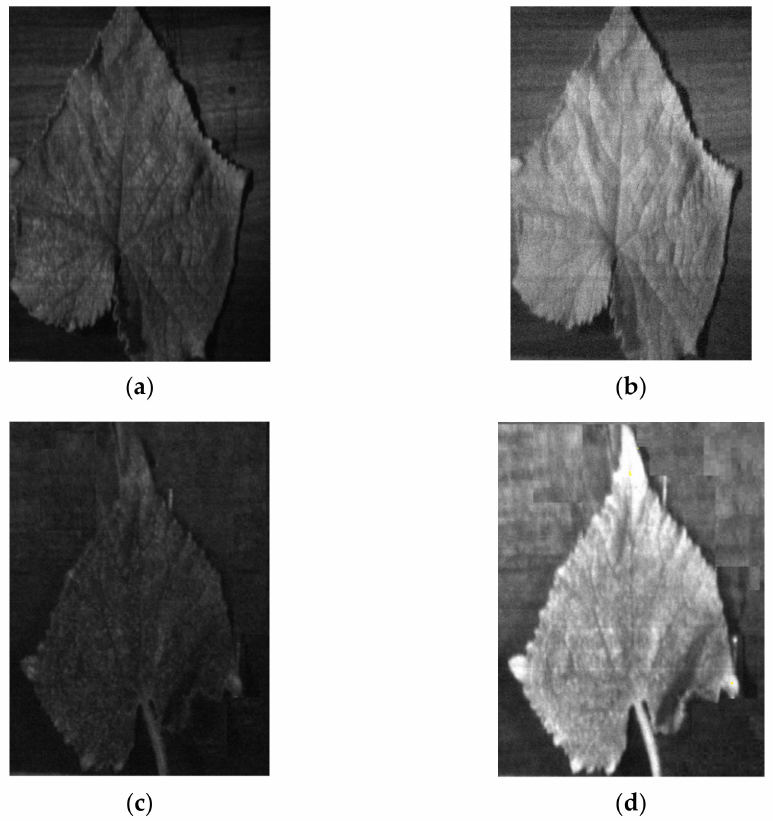
Figure 11. Sample images of the cucumber leaves at different wavelengths. Upper row ( a , b ): without treatment (D0); lower row ( c , d ): after 1 day of application of excess nitrogen (D1). Left column ( a , c ): wavelength in the visible band (582 nm); right column ( b , d ): wavelength in the near-infrared range (NIR) band (908